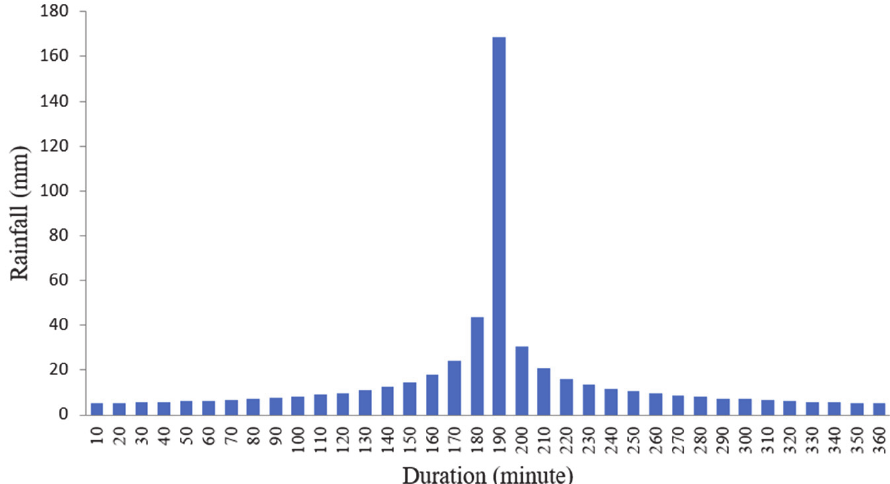
Figure 3. Alternating Block Method (ABM) Log ‐ Pearson Type III Distribution .